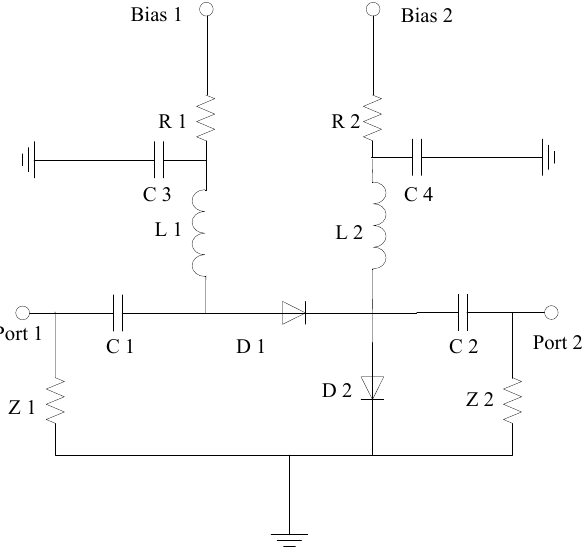
Figure 8. Circuit schematic of the series-shunt PIN switch. Table 3. Comparison of insertion loss and isolation for di ff erent